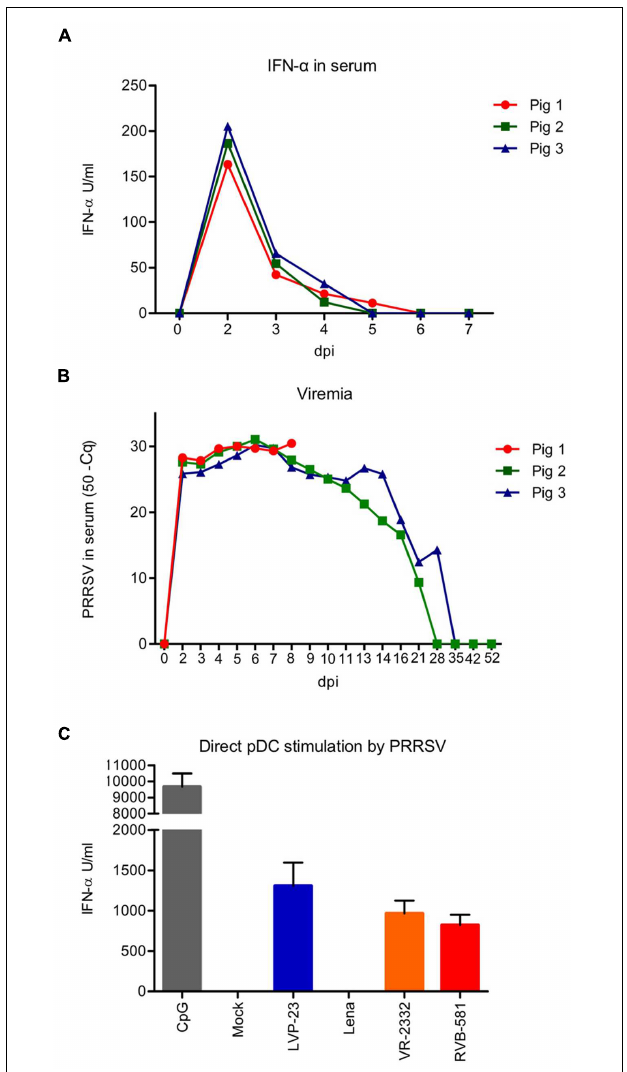
FIGURE 1 | The porcine reproductive and respiratory syndrome virus (PRRSV) Lena strain induces IFN- α in infected animals but cannot directly activate pDC in vitro . (A) Serum IFN- α responses of pigs infected oronasally with PRRSV Lena (5 × 10 5 TCID 50 per animal), as determined by ELISA. (B) Viral RNA loads in the serum. The data was obtained using RT-qPCR for PRRSV ORF7 and is represented as the total number of cycles minus the quantification cycle (Cq)-value. (C) Comparative analysis of IFN- α production by enriched pDC in response to PRRSV-1 (LVP-23 and Lena) and PRRSV-2 strains (VR-2332 and RVB-581) after stimulation with a MOI of 0.1 TCID 50 /cell. CpG D32 was included as control. The supernatants were harvested after 20 h of incubation and IFN- α was quantified by ELISA. The data represent the mean IFN- α (U/ml) of triplicate cultures, with error bars representing the standard deviation. These results are representative of at least three independent